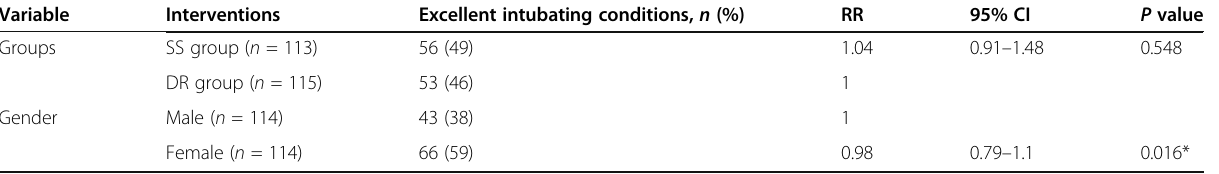
Table 4 Excellent intubating conditions between studied groups (primary outcome) Variable